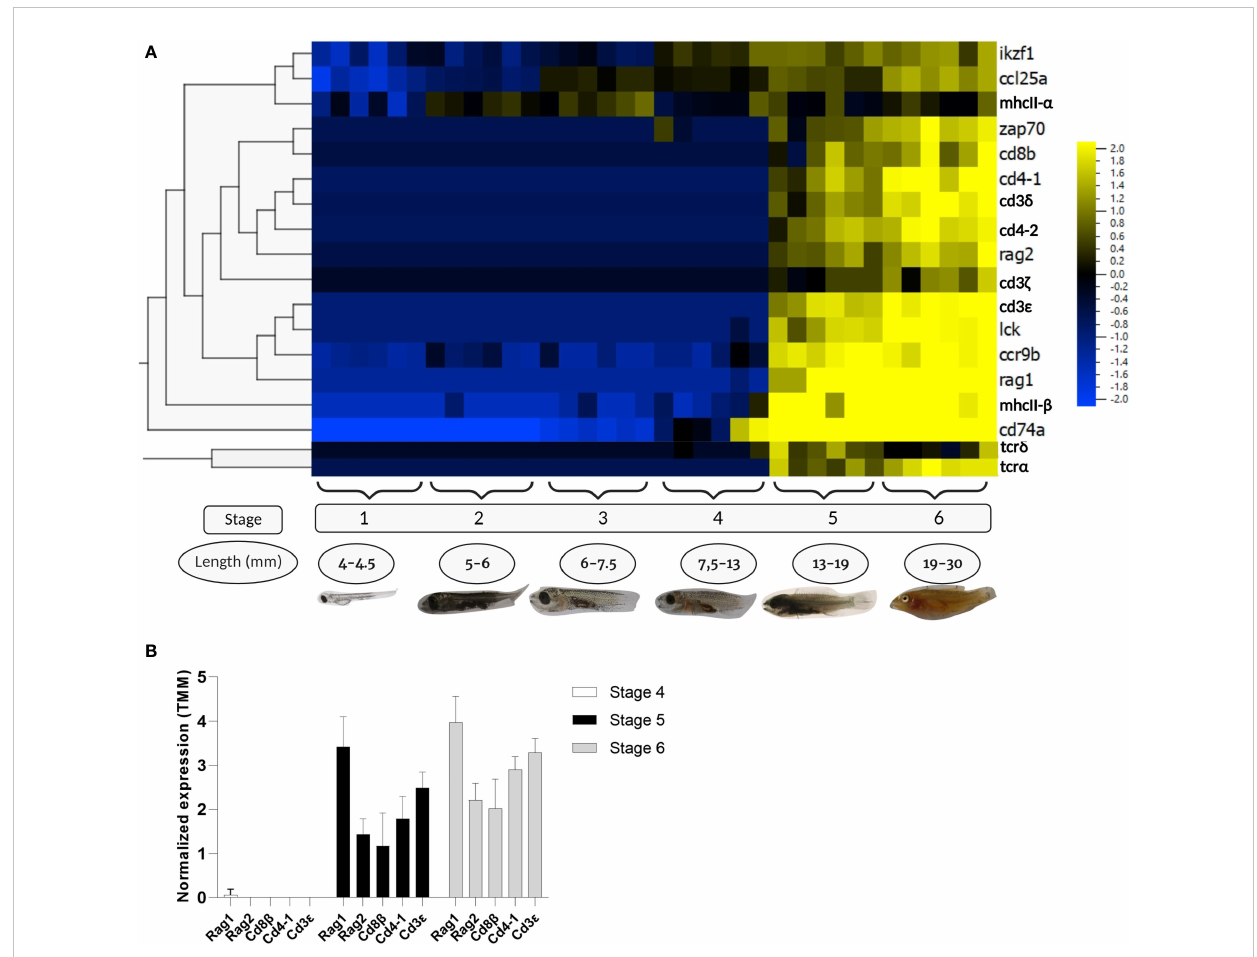
FIGURE 4 RNA transcriptomic data from different stages of wrasse larvae. Data were logarithm converted, normalized for differences in library size applying weighted trimmed mean expression ratios [trimmed mean of M values (TMM)], and expressed as mean = 0. (A) Heat map of RNA transcripts showing hierarchical clustering of the selected T-cell markers and non-lymphocytic thymus cells markers in the developmental stages of ballan wrasse. The fi gure was generated using Qlucore omics explorer software. (B) RNA transcripts of T-cell markers corresponding to RAG1 , RAG2, CD8 b , CD4-1 , and CD3 ϵ from larvae at stage 4, 5, and 6. Created with